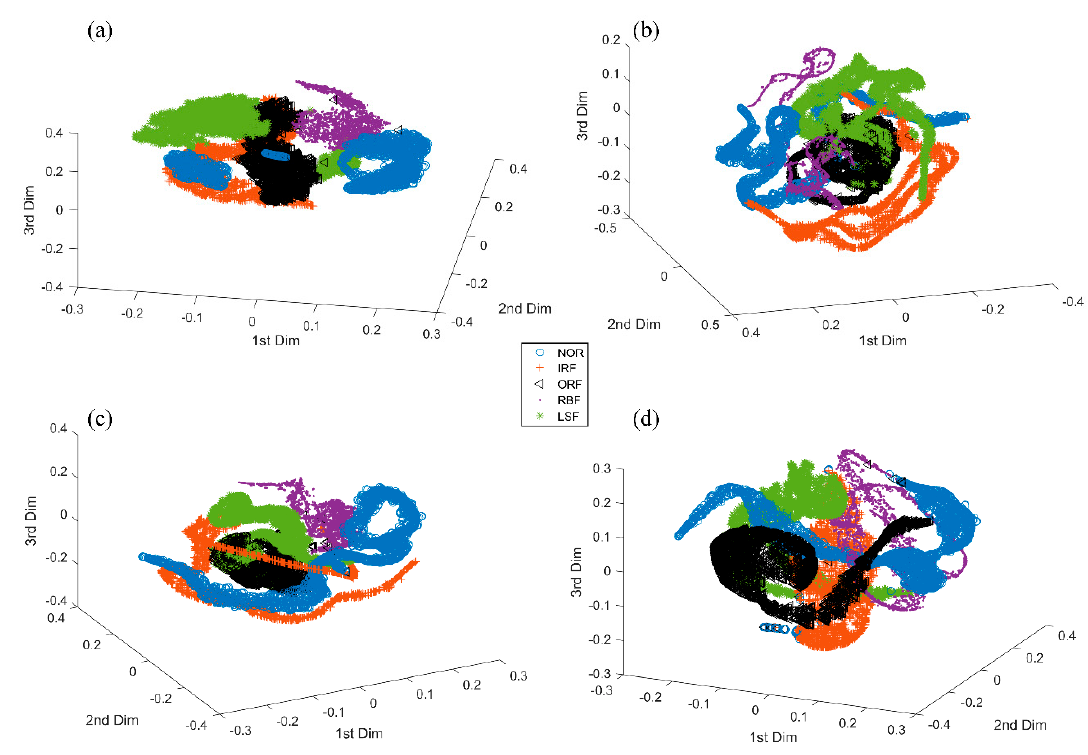
Figure 18. Comparison of di ff erent feature clustering maps from ( a ) WPT-CNN; ( b ) VGGNet; ( c ) 2D-CNN; ( d ) 1D-CNN in Case Two. Table 13. Cost time of di ff erent methods on Dataset A in Case